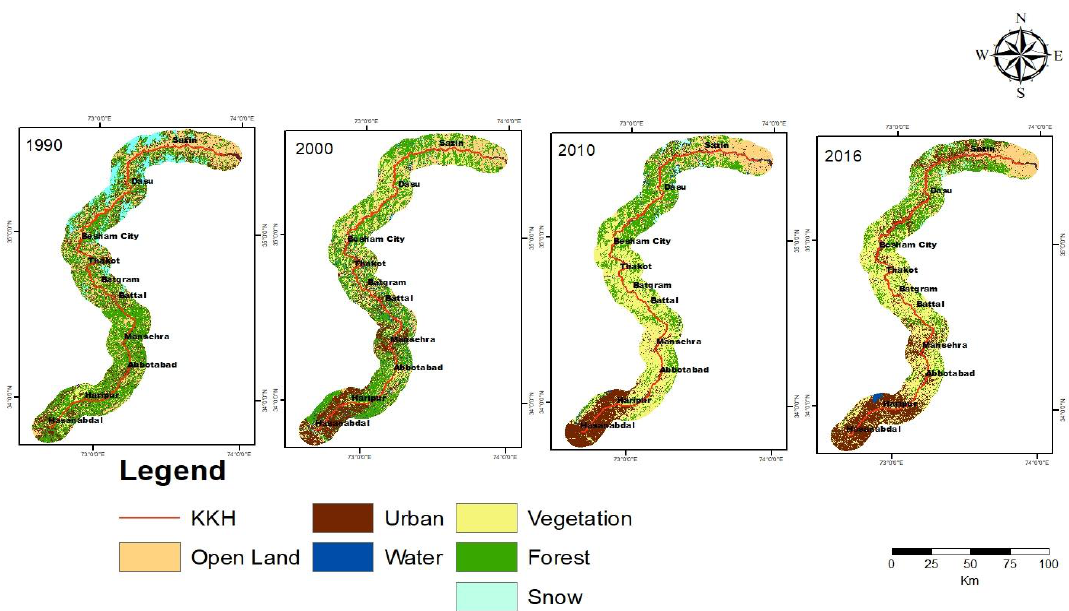
Figure 3 Forest cover dynamics from 1990 to